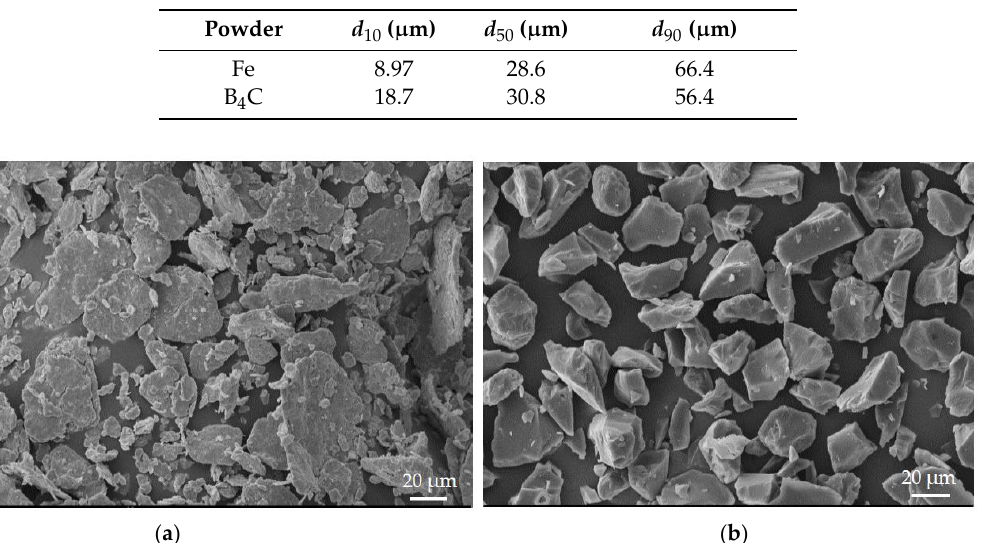
Table 1. Particle size distributions of the raw powders.